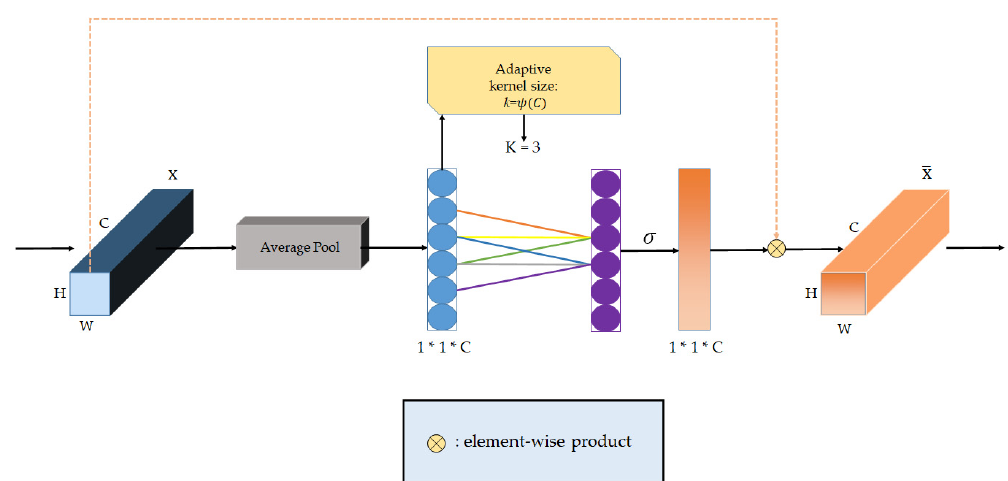
Figure 5. Channel attention module.